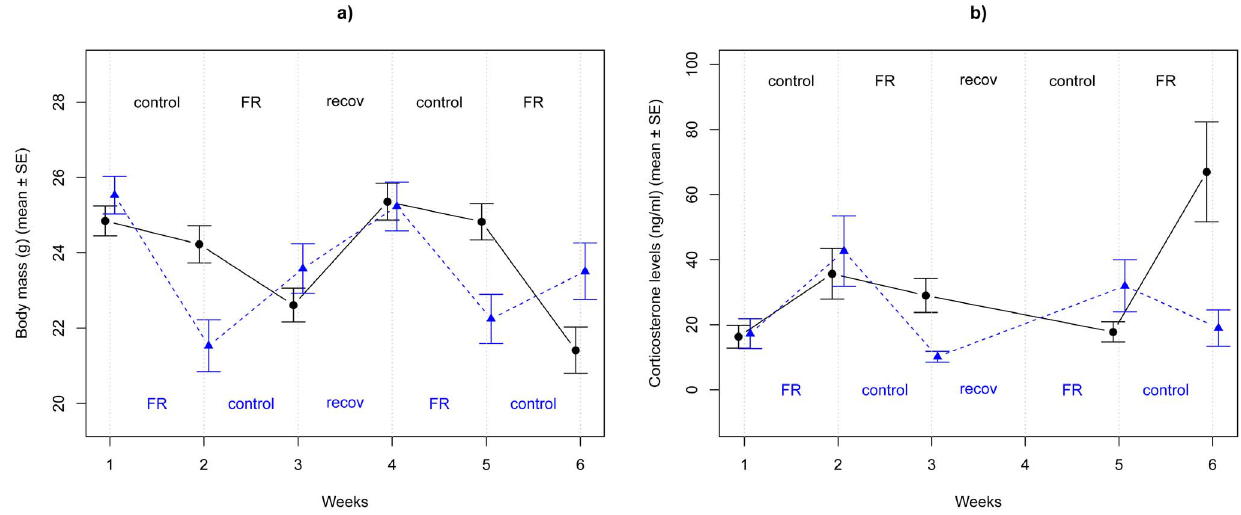
Figure 2. Mean ± SE (a) body mass (b) corticosterone levels during the experiment. Birds received either a food restricted (’FR’) or a control diet, which corresponded to 60% or 110% of their daily food consumption, respectively. During the third week of the experiment, all birds received ad libitum food for one week (’recov’). Birds were randomly allocated into two groups that differed only in the order of the treatments. Black dots and solid lines represent birds starting with the control diet (treatments indicated above the lines), blue triangles and dotted lines represent birds starting with the food restricted diet (treatments indicated below the lines). Note that blood samples were not collected after the recovery period (after week 3), but body mass was recorded.